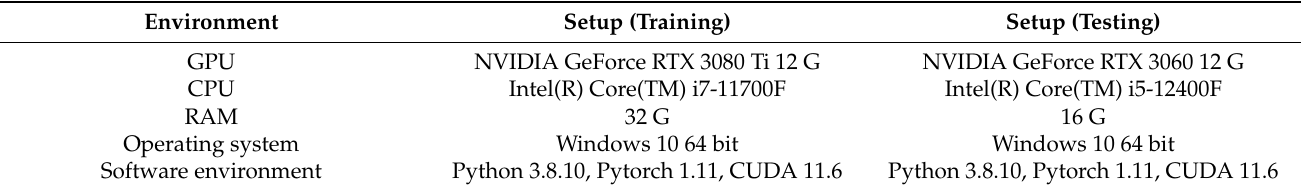
Table 1. Training and testing